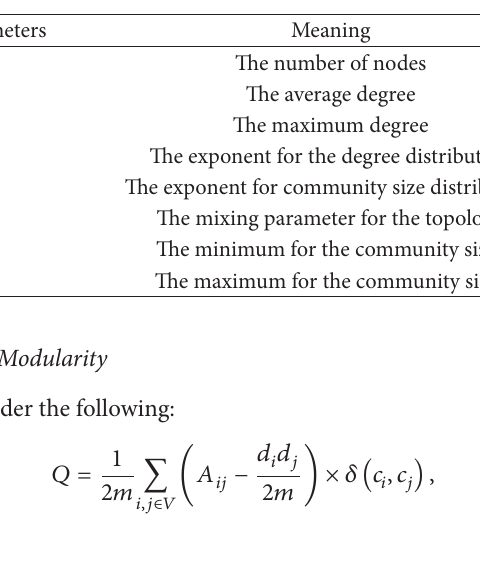
Table 2: The main parameters of LFR.